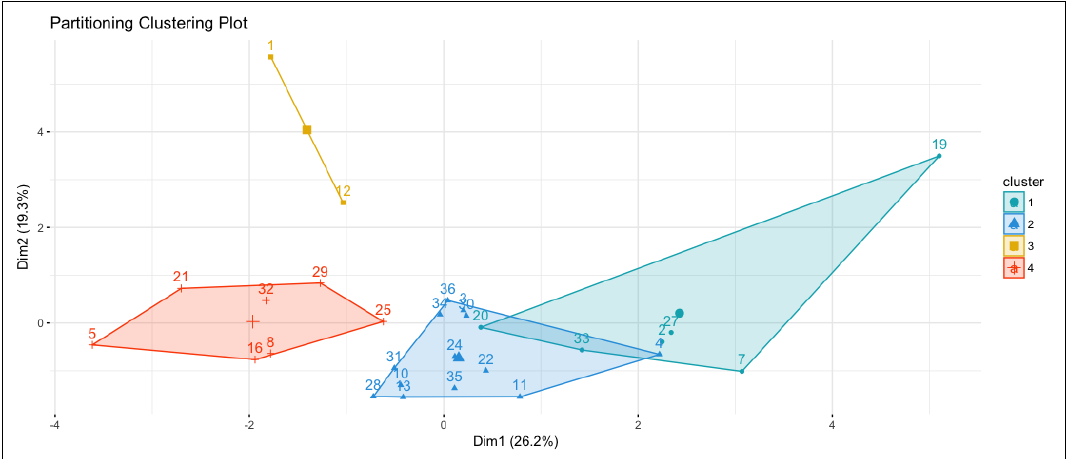
Figure 4. Drivers classified into groups using 20 features. Groups are in order from safer to riskier: 1, 2, 4,